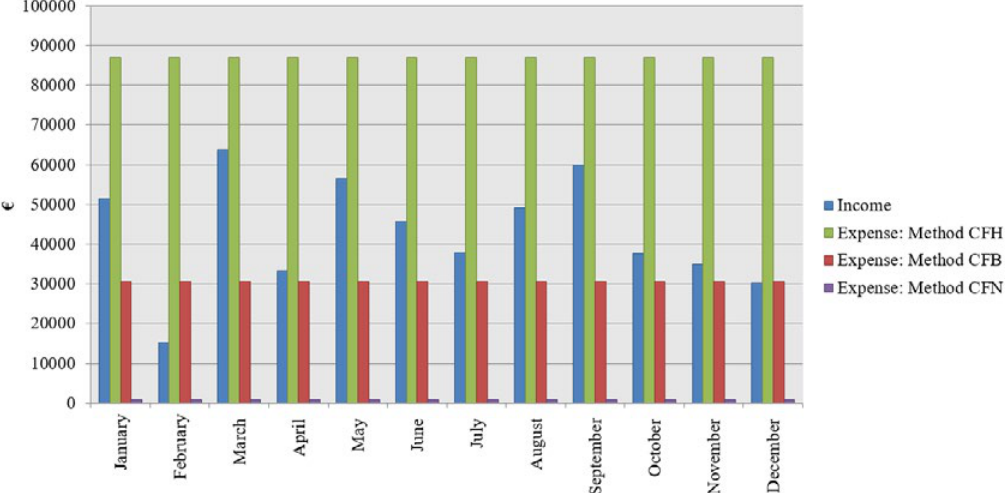
Fig. 13: Method comparison chart